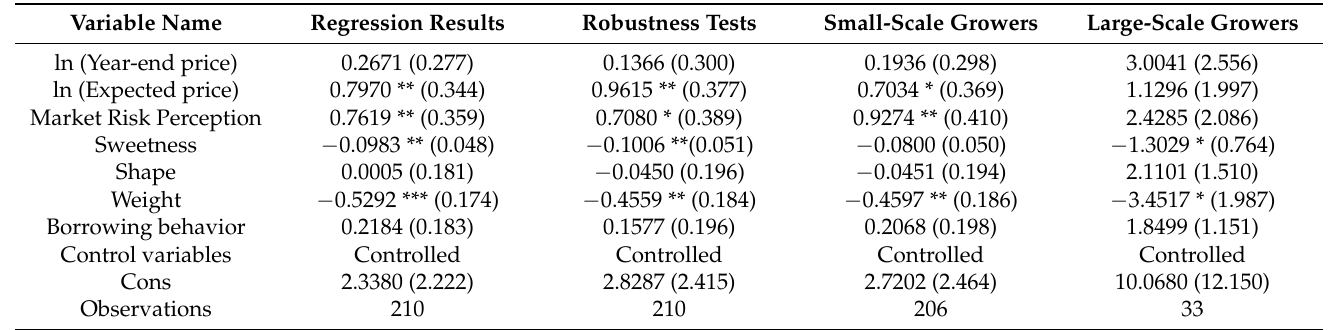
Table 6. Regression results related to long- and short-term decisions of